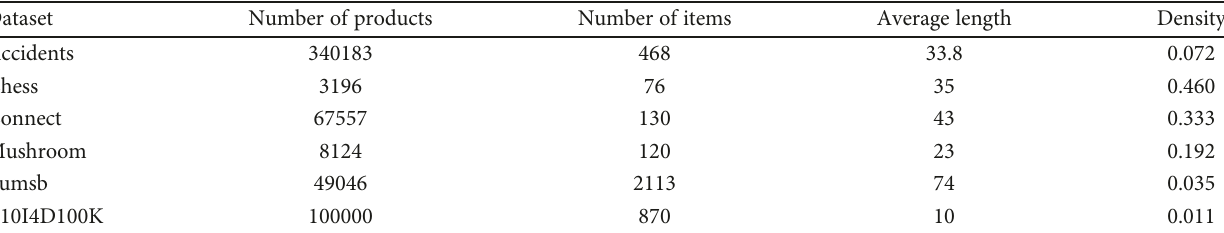
Figure 1: Illustration of the mining process of MEI and pMEI. Table 2: Dataset descriptions.